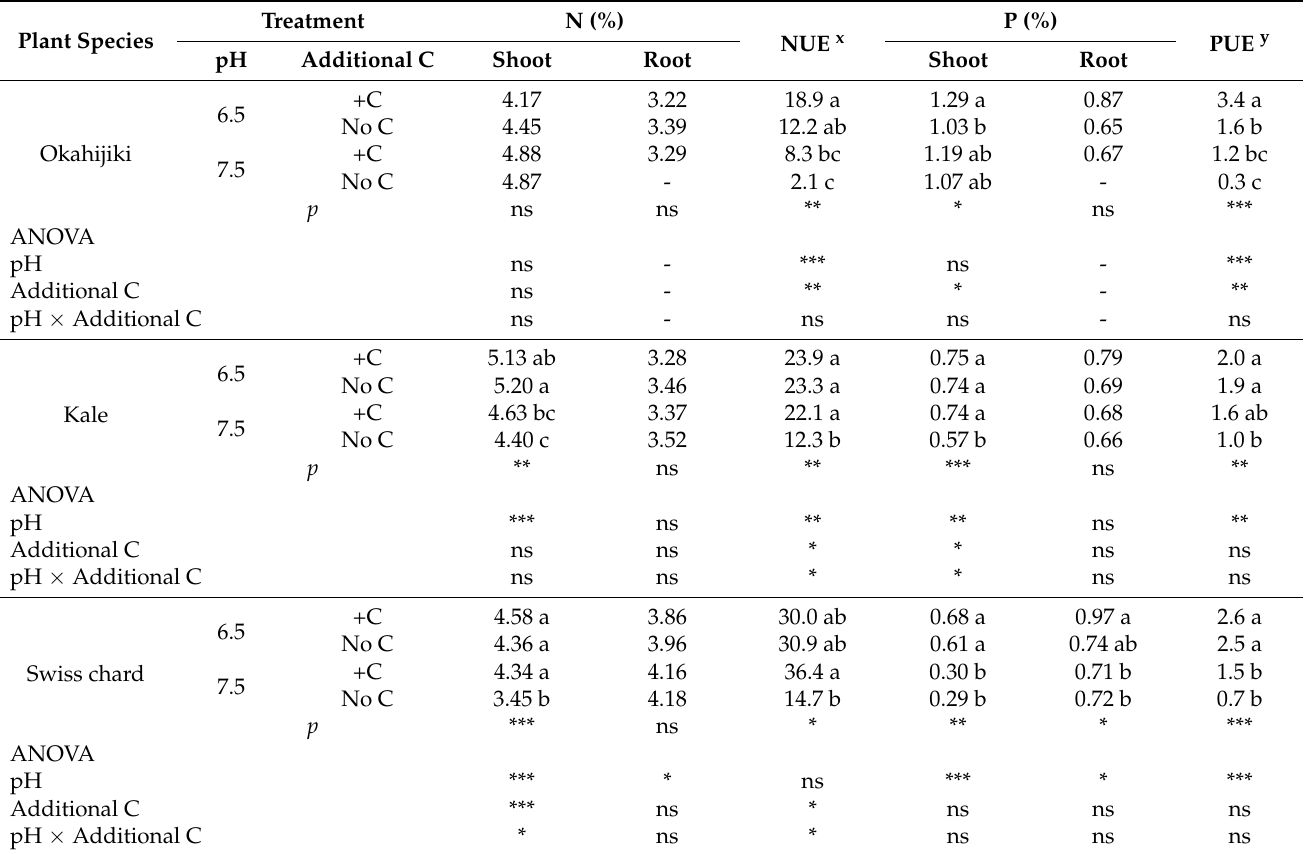
Table 7. Average nutrient content and nutrient use efficiency of okahijiki, kale, and Swiss chard from the second harvest.